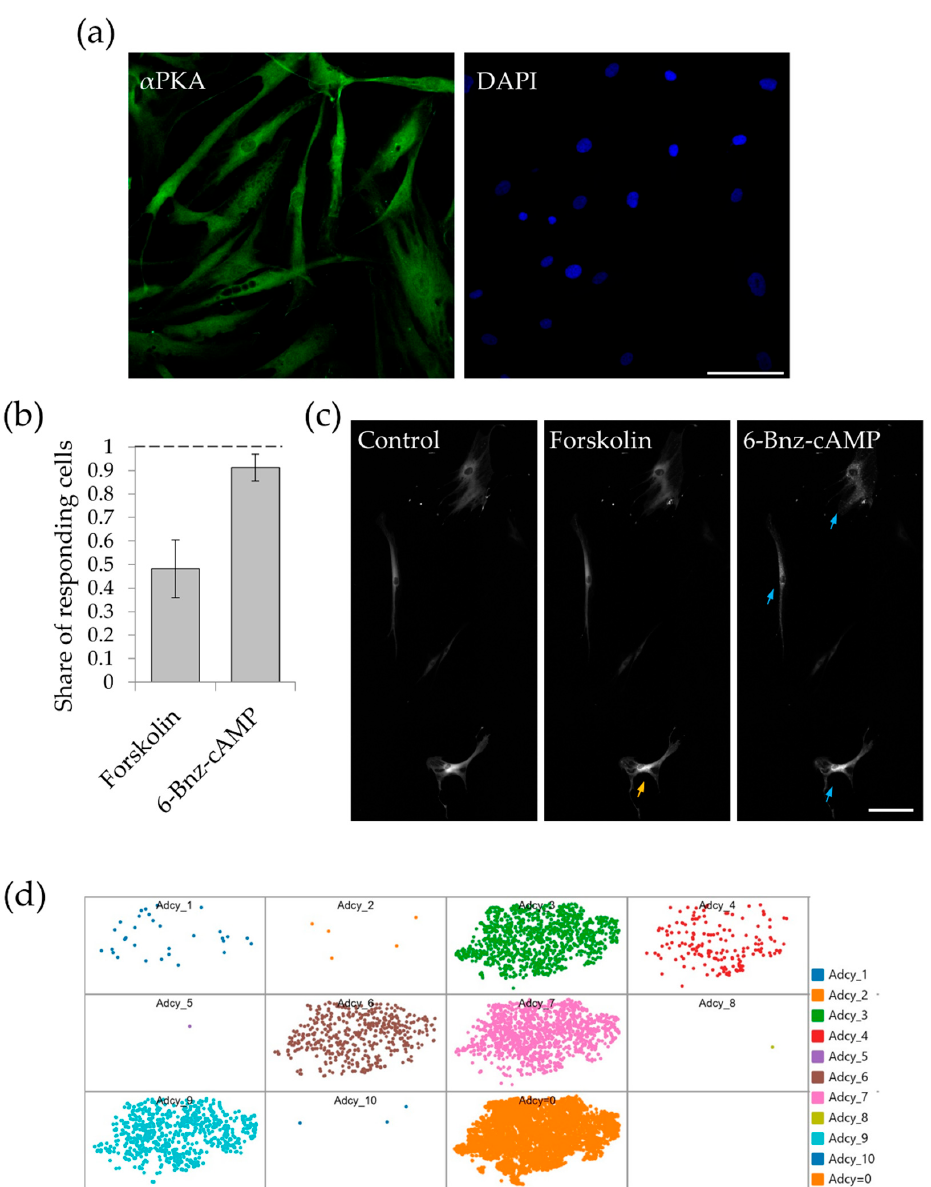
Figure 1. Multipotent stromal cells (MSC) response to adenylate cyclase and protein kinase A (PKA) activation. ( a ) Immunofluorescent staining of the catalytic subunit of protein kinase A in MSC. Scale bar 100 µm. ( b ) Share of the cells responding to adenylate cyclase activator forskolin (10 − 6 M) and cell-permeable direct activator of protein kinase A 6-Bnz-cyclic AMP (10 − 4 M). Results are presented as mean ± SE, n = 17–24 in 4 independent experiments on the material of 3 different donors. ( c ) Representative field of view of the cells responding to the sequential adding of forskolin and 6-Bnz-cAMP. Yellow arrow marks the cell responded to the forskolin added. Blue arrows show the cells responded to 6-Bnz-cAMP added. Scale bar 100 µm. ( d ) Expression of mRNA of different isoforms of adenylyl cyclase in human MSC population. Raw data of scRNAseq analysis of MSC were downloaded from Reference [19].